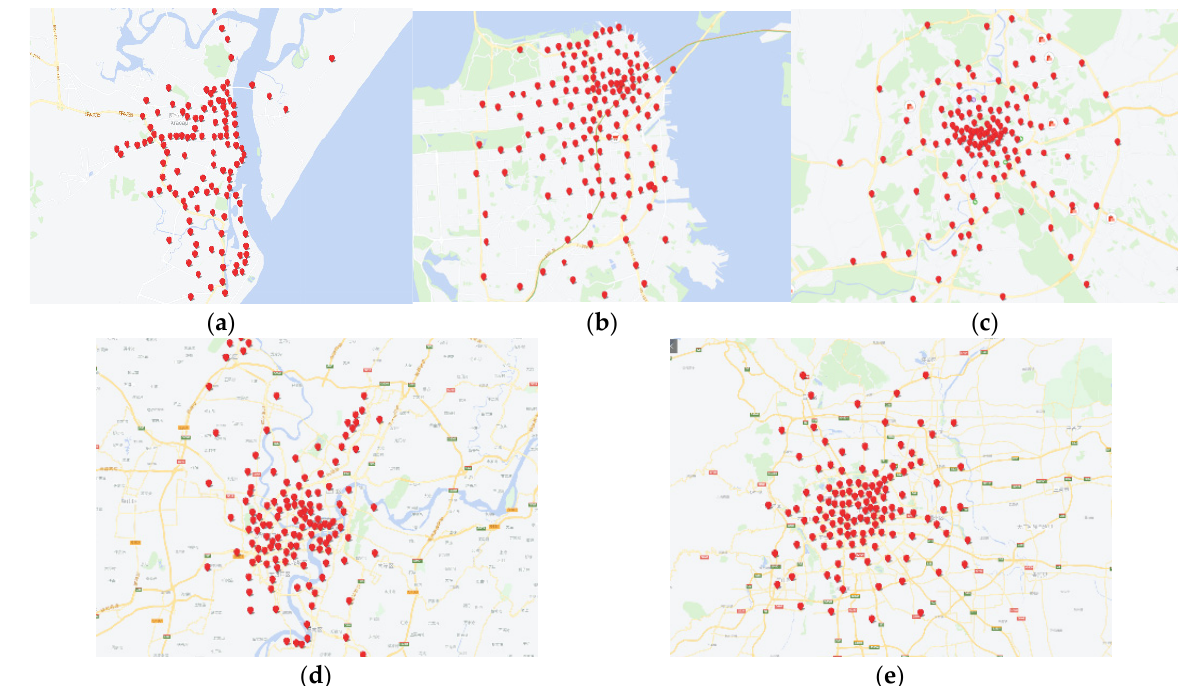
Figure 10. The city hotspot markers for the city taxi GPS data found by the K-means method: ( a ) Aracaju (Brazil), ( b ) San Francisco (USA), ( c ) Rome (Italy), ( d ) Chongqing (China), ( e ) Beijing (China).